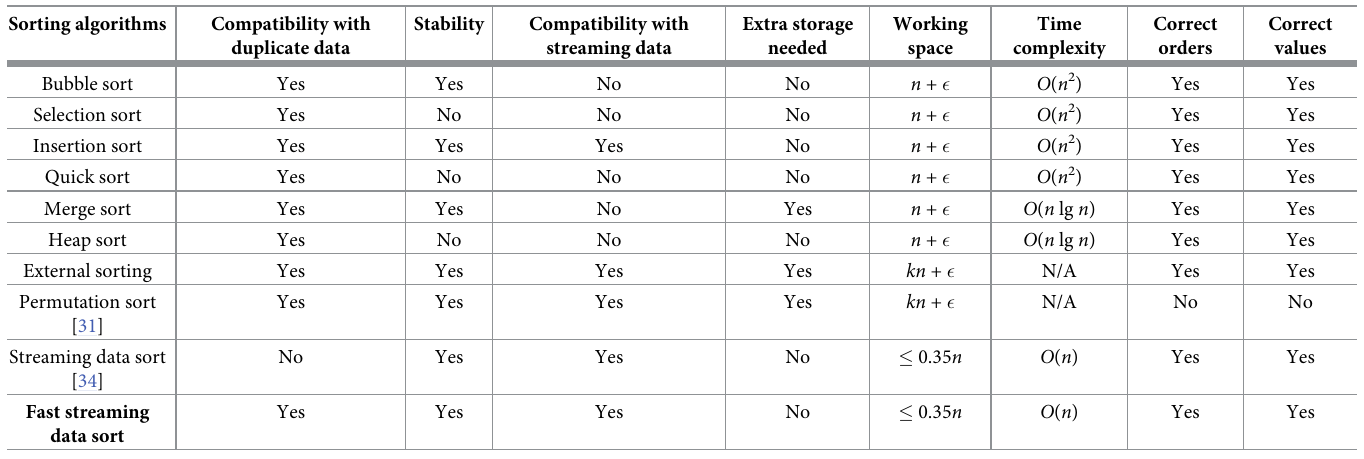
Table 1. Comparison of sorting algorithms on streaming data. Sorting